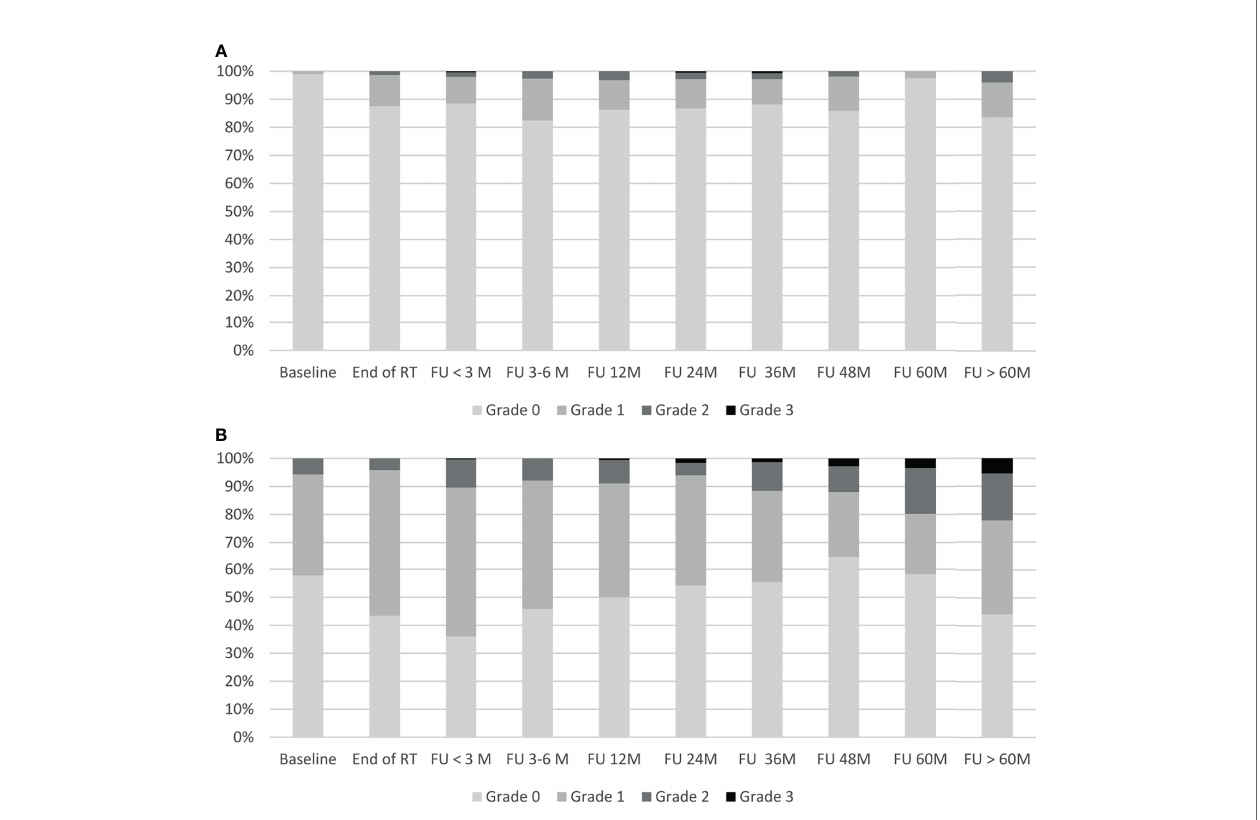
FIGURE 4 | Gastrointestinal and genitourinary toxicity. Shown is the time course of physician-recorded gastrointestinal toxicity (A) and genitourinary toxicity (B) according to CTCAE v5.0. RT, radiotherapy; M, months; FU,